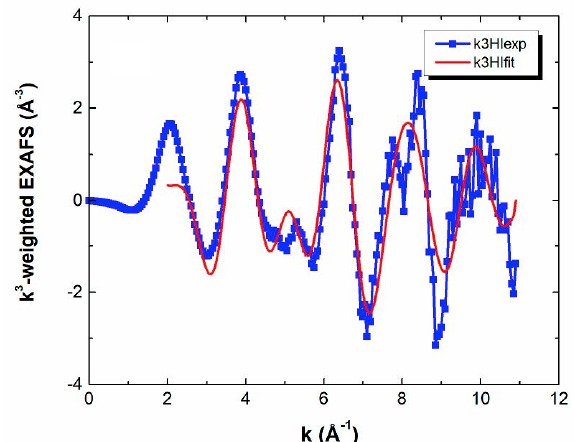
Figure 3. Extended X-ray absorption fine structure EXAFS k3χ(k) spectra of IrQ(ppy) 2 experiments.